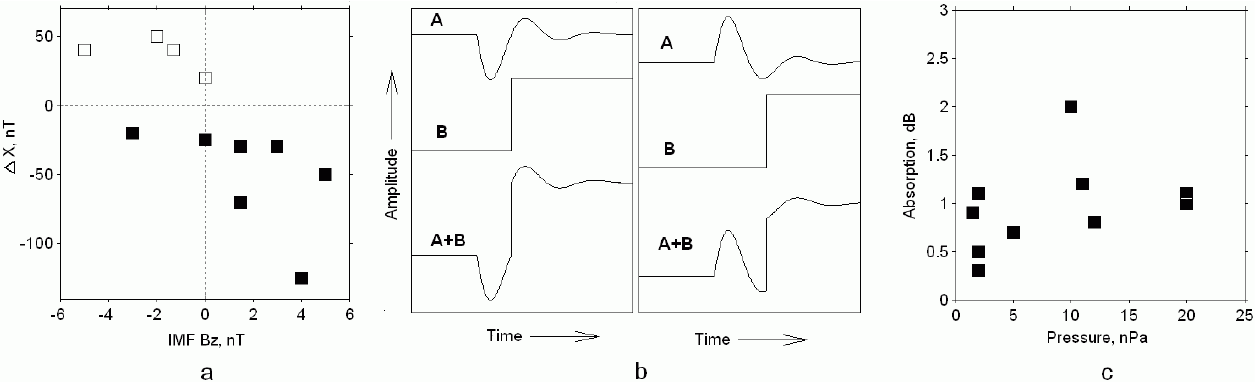
Fig. 8. (a) Dependence of the polarity of preliminary magnetic disturbance on the sign of IMF B z component; (b) sketch illustrating the presentation of the high-latitude disturbance as a sum of oscillations and step-like increase; (c) amplitude of SCA vs amplitude of